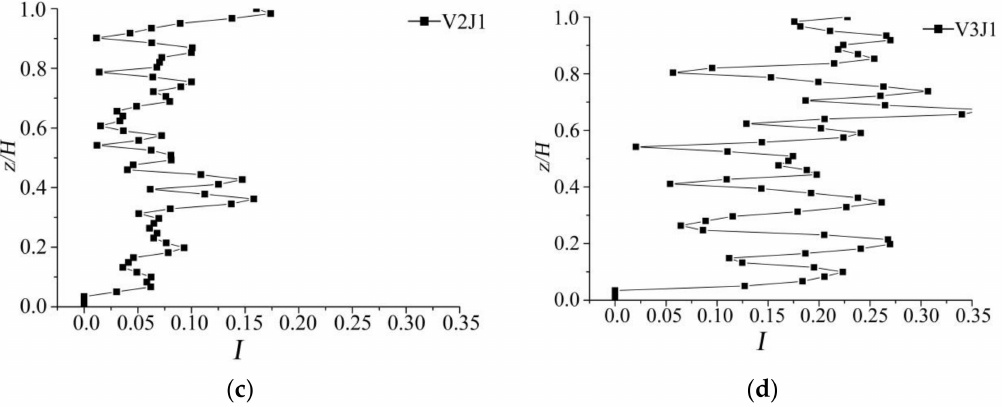
Figure 8. Vertical distribution of relative turbulence intensity. ( a ) The dimensionless turbulence intensity for run V0J1; ( b ) The dimensionless turbulence intensity for run V1J1; ( c ) The dimensionless turbulence intensity for run V2J1; ( d ) The dimensionless turbulence intensity for run